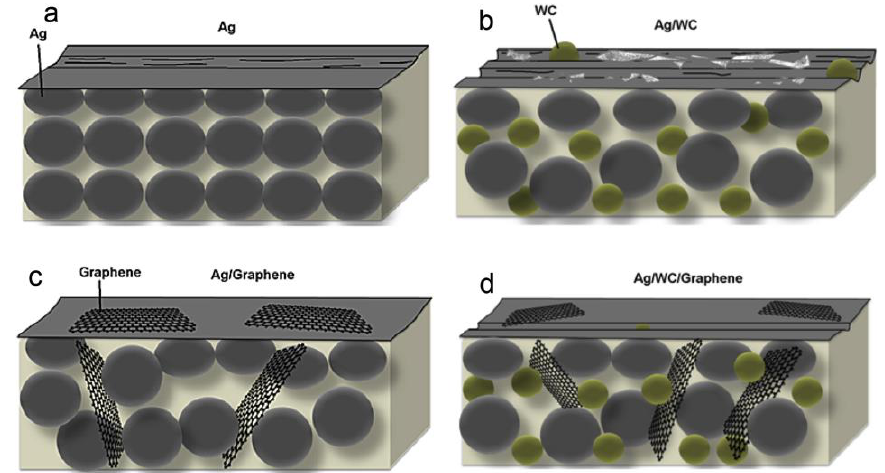
Figure 6. Schematic representation of worn surface: ( a ) adhesive wear in pure Ag, ( b ) abrasive grooves in Ag/WC, ( c ) graphene lubrication in Ag/Graphene, and ( d ) mixed mode of wear in Ag/WC/Graphene [103]. (Reproduced from [103] with permission; Copyright 2016 Elsevier).